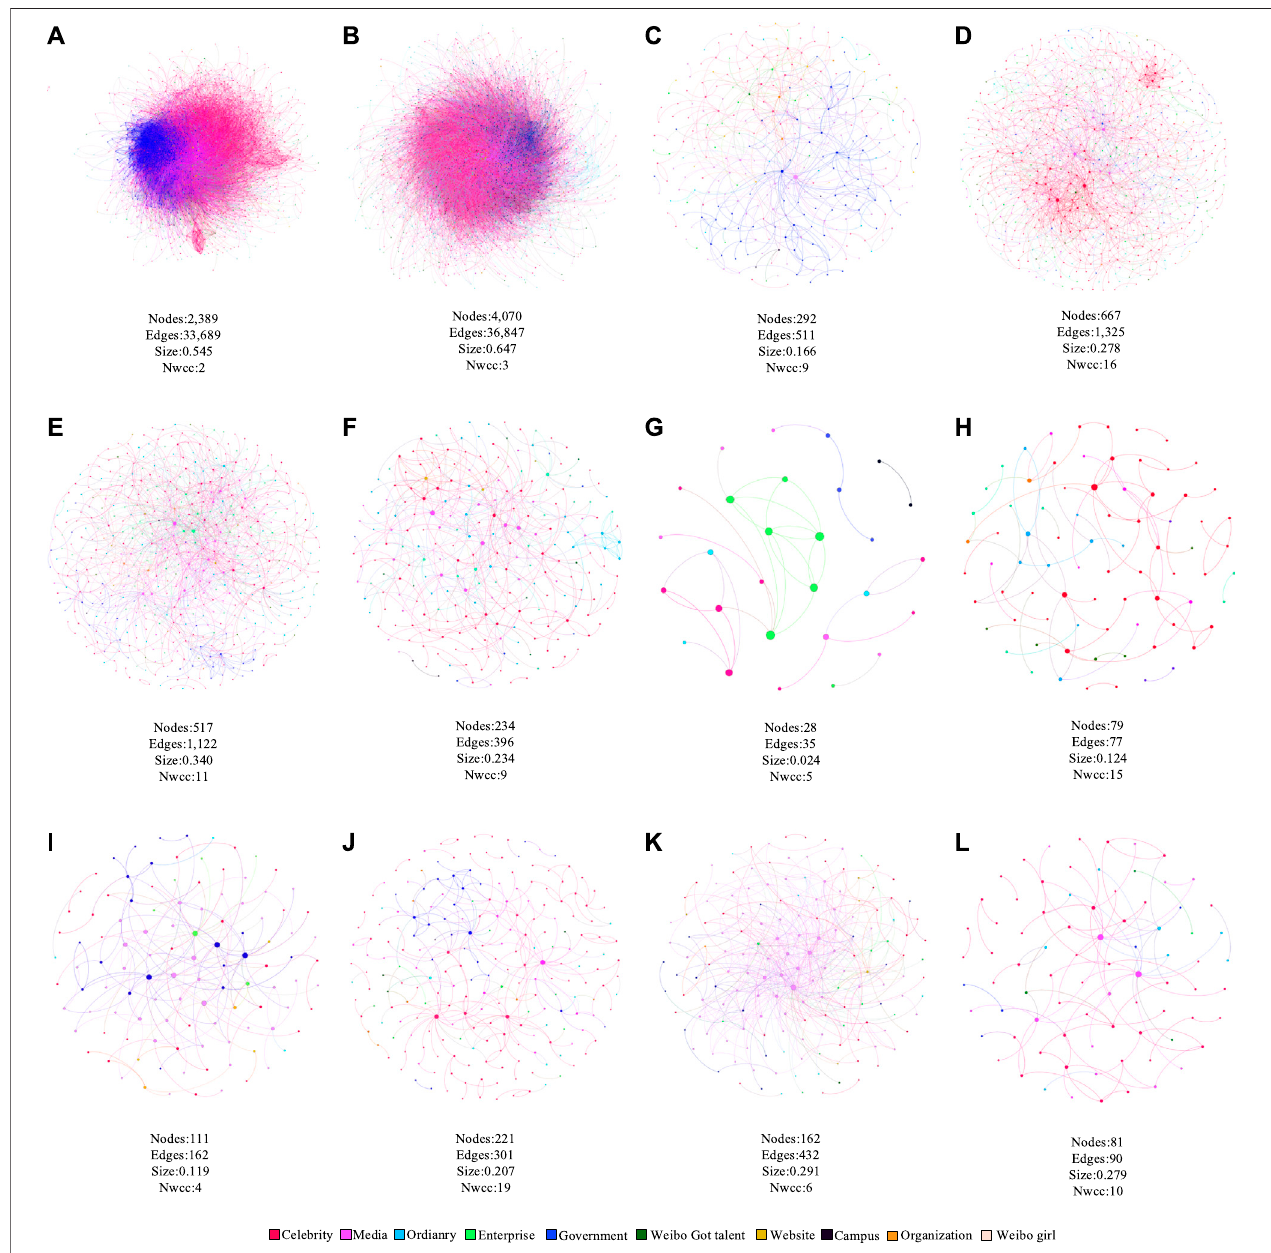
FIGURE6| k -coredecompositions ofSRNs under sixtypes offakenews: (A) SRNofrefuters after k -coredecomposition(R k – R k ) insociety-related fakenews, (B) SRNofnon-refutersafter k -coredecomposition(NR k – NR k )insociety-relatedfakenews, (C) R k – R k inhealth-relatedfakenews, (D) NR k – NR k inhealth-relatedfakenews, (E) R k – R k inbusiness-relatedfakenews, (F) NR k – NR k inbusiness-relatedfakenews, (G) R k – R k inscience-relatedfakenews, (H) NR k – NR k inscience-relatedfakenews, (I)